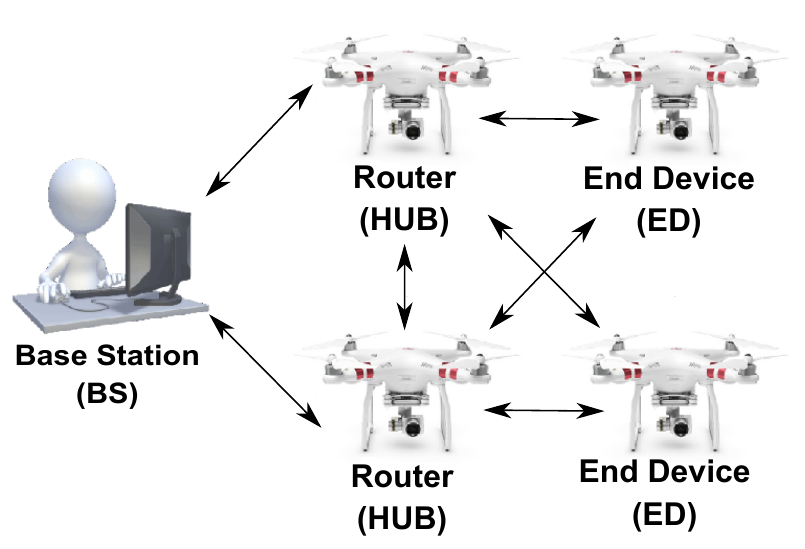
Figure 11. ZigBee devices in a scenario FANET test with mesh